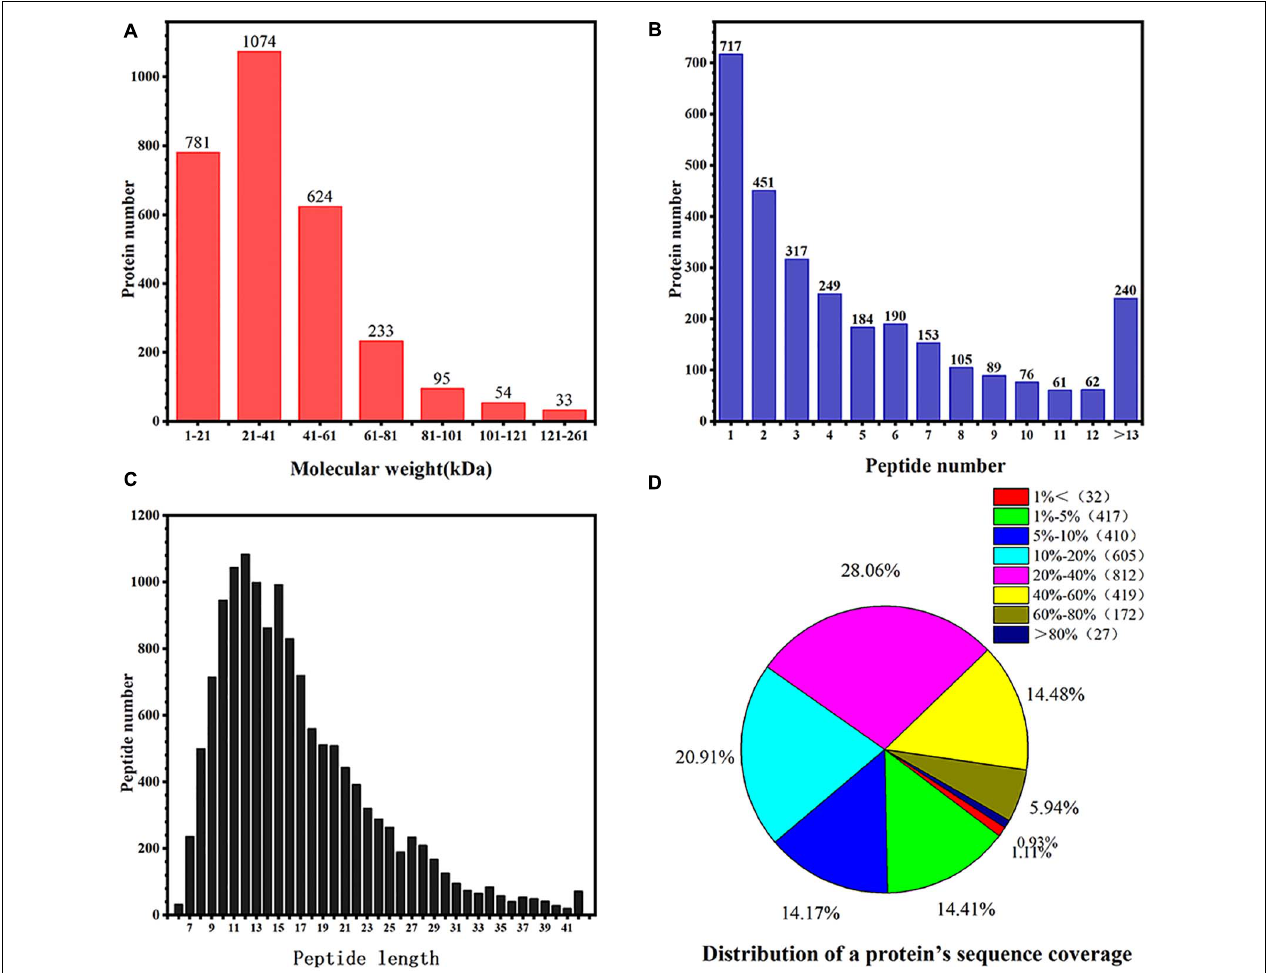
FIGURE 3 | Identification and analysis of the proteome of rhubarb. (A) Protein molecular weight in rhubarb; (B) numbers of peptide identified into the rhubarb proteins; (C) the percentage of different peptide lengths in total amino acids. (D) Distribution of a protein’s sequence coverage.